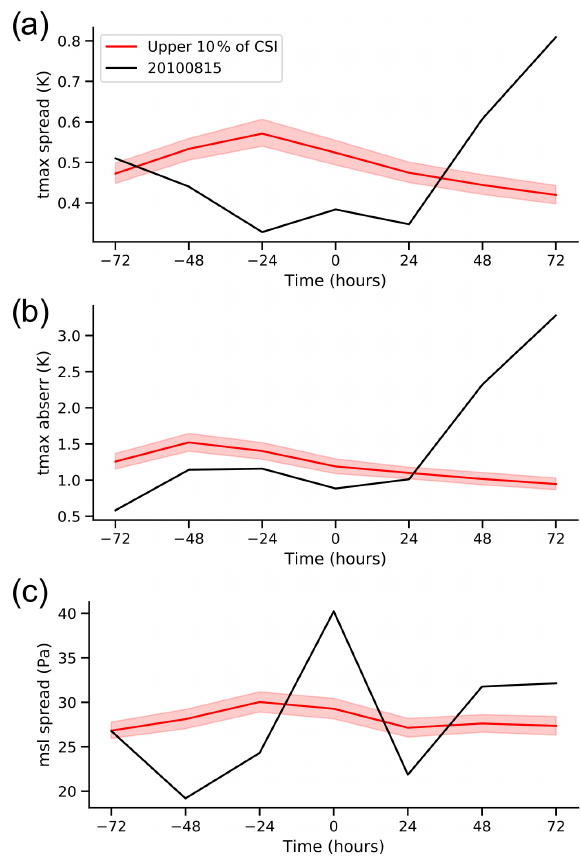
Figure 9. Forecast spread and skill for the mid-August 2010 heat wave, centered (0h) on 15 August 2010 at 12:00UTC (black line). The mean temporal evolution of the ensemble model spread for T max (a) , SLP (c) and the absolute error for T max (b) of forecasts with a lead time of 69h, initialized at different time lags with respect to the event, computed every 24h. The heat waves (upper 10% of CSI – red lines) are displayed for reference. A 95% bootstrap con- fidence interval for all heat waves is displayed